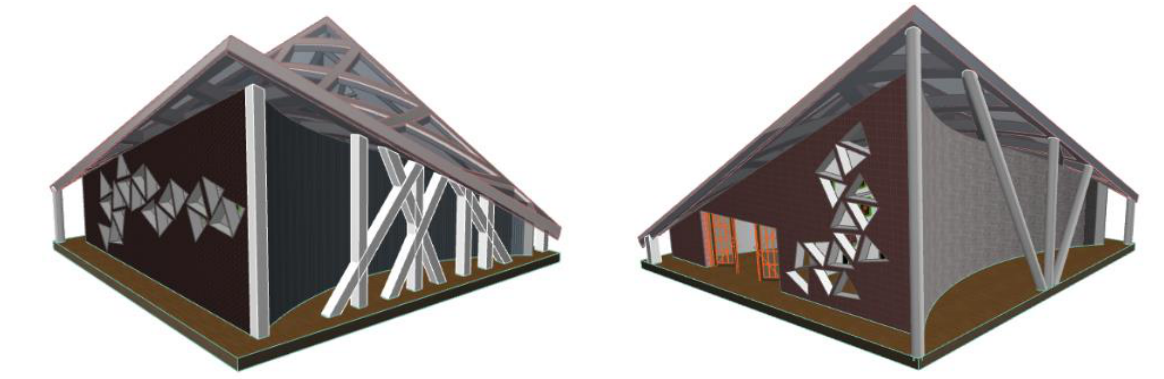
Figure 1. General form of the exhibition hall designed via Archicad.